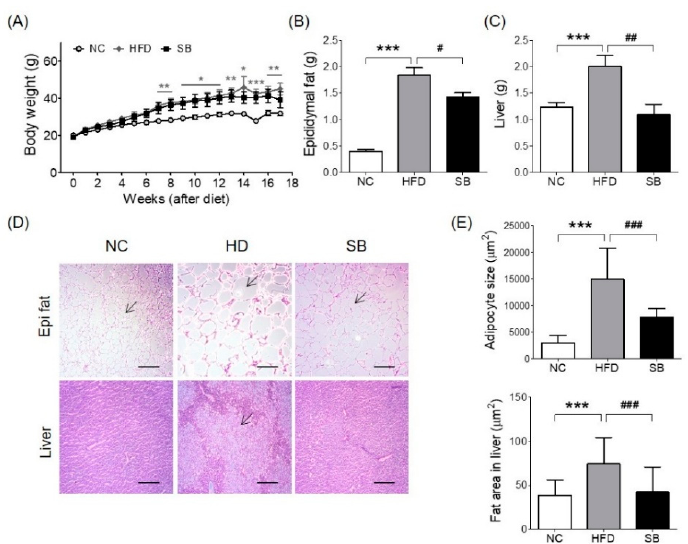
Figure 1. Effects of SB on body weight ( A ), epididymal fat ( B ), liver weight ( C ), histological changes in epididymal fat and liver. Representative histological images were assessed by hematoxylin and eosin (H&E) staining, scale bar indicates 100 μ m, and arrow indicates adipocyte in Epi fat, 25 μ m and arrow indicates fat deposition area in Liver ( D ), adipocyte size and fat area in liver ( E ). n = 6 in each group. Data shown as mean ± standard error of the mean (SEM). * p < 0.05, ** p < 0.01, *** p < 0.001, HFD compared with NC; # p < 0.05, ## p < 0.01, and ### p < 0.001, HFD compared with SB.